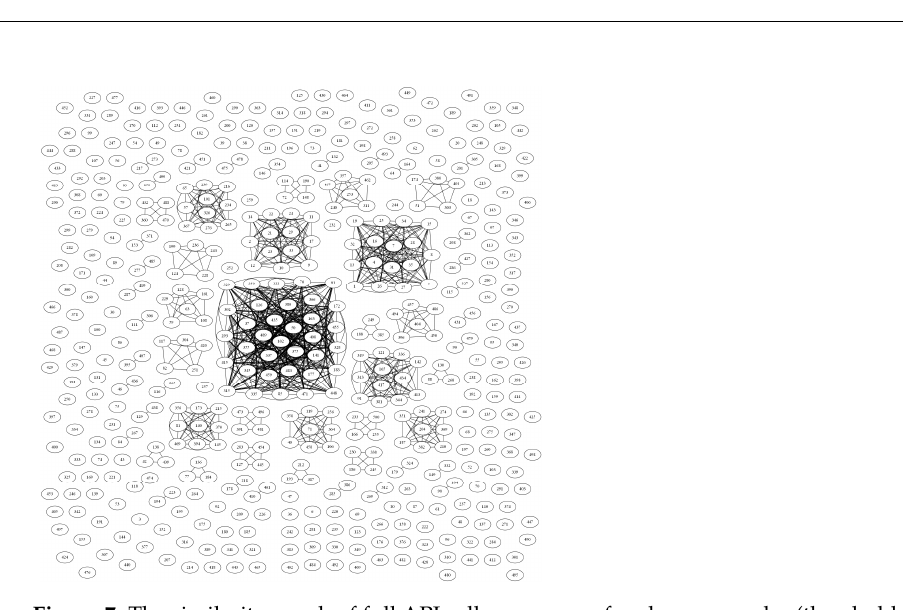
Figure 7. The similarity graph of full API call sequences of malware samples (threshold = 0.5).